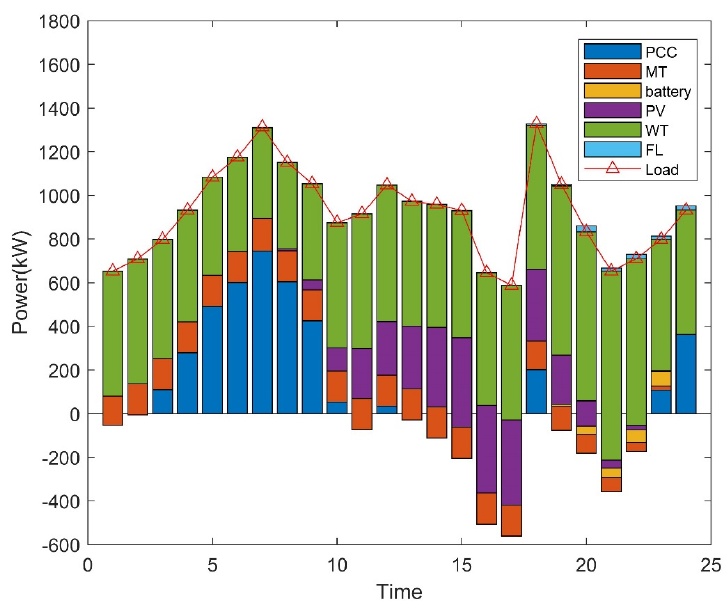
Figure 4. Optimal dispatch of VMG1.